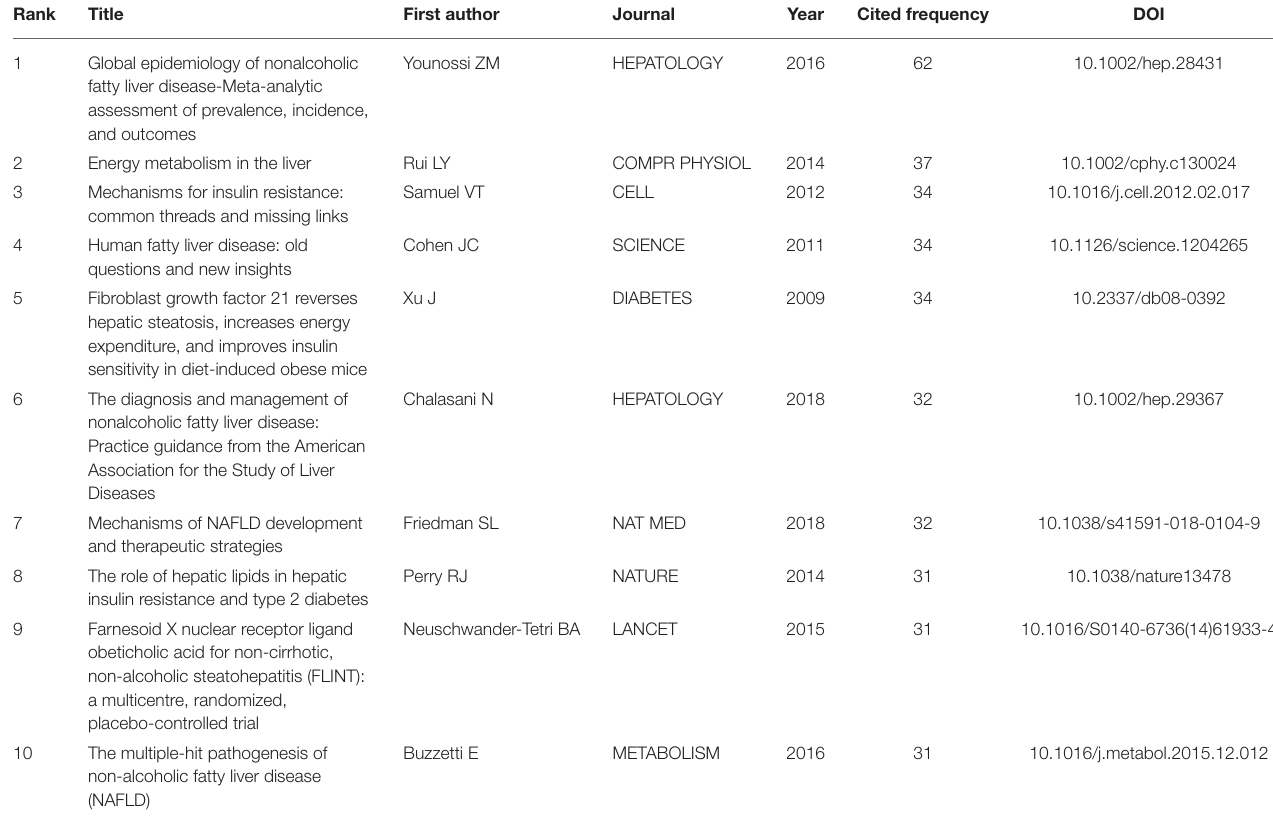
TABLE 2 | The top 10 high-cited papers in the hepatic glucolipid metabolism field during 2002 to 2021.